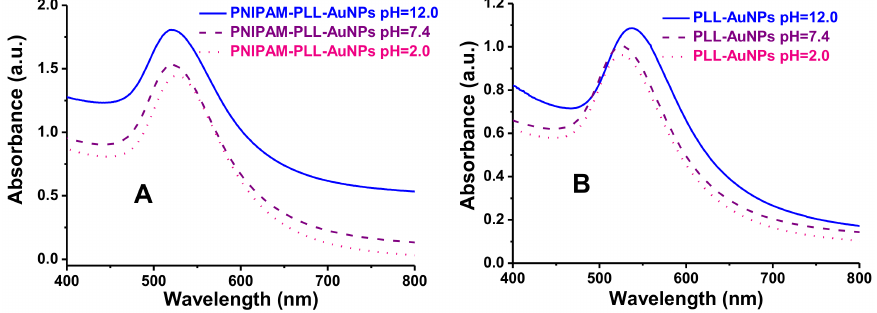
Figure 8. UV-vis absorption spectra as a function of pH of PNIPAM-PLL-AuNPs ( A ) and PLL-AuNPs ( B ) at room temperature (Concentration: 2.0